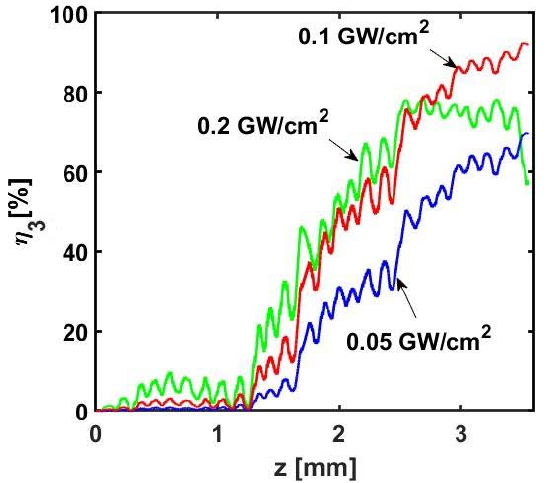
Figure 10. Intensity conversion efficiency from the fundamental frequency to its 3rd harmonic, calculated for different input intensities (as marked) and the designed APP − LN lattice (Figure 5) with equal domain sizes in each segment.